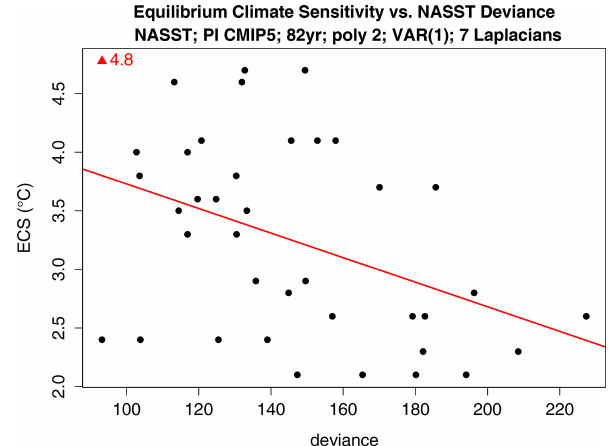
Figure 9. Deviance versus equilibrium climate sensitivity of CMIP5 models. The deviance is computed for NASST separately for the first and second halves of the 1854–2018 period, which yields two points per CMIP5 model for a total of 72 points. ECS is derived from Table 9.5 of Flato et al. (2013). The red line shows the least-squares line fit, and the red triangle at the top shows the intercept of the best-fit